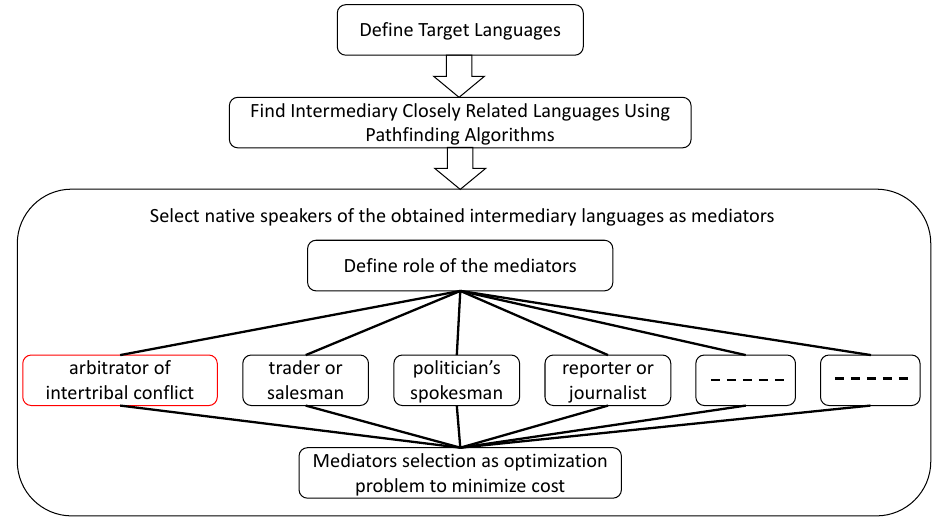
Figure 2. Mediator Selection